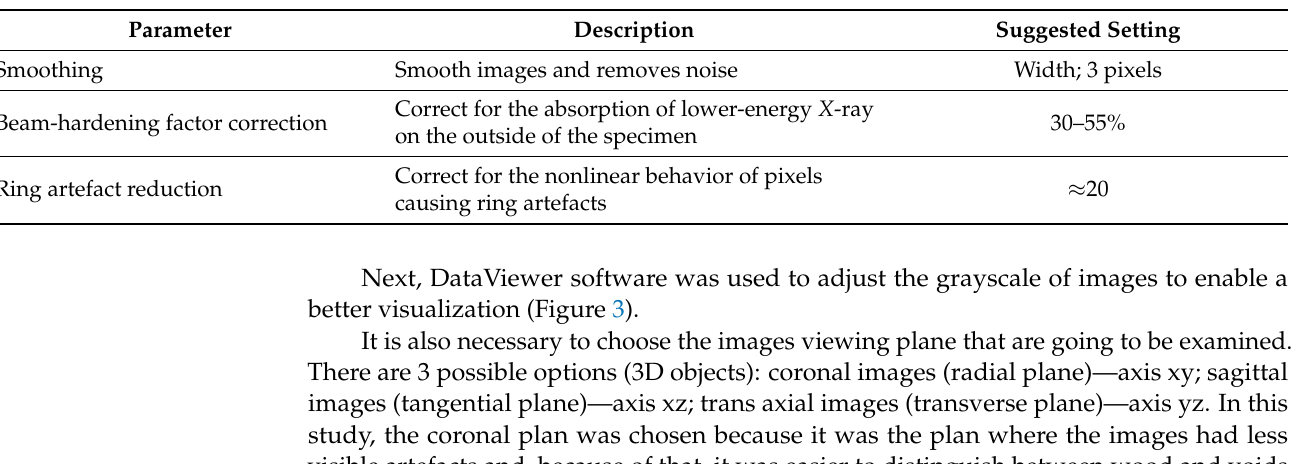
Table 2. Reconstruction parameters adopted using NRecon software. Parameter Description Suggested Setting Smoothing Smooth images and removes noise Width; 3 pixels Correct for the absorption of lower-energy X -ray Beam-hardening factor correction on the outside of the specimen Correct for the nonlinear behavior of Ring artefact reduction